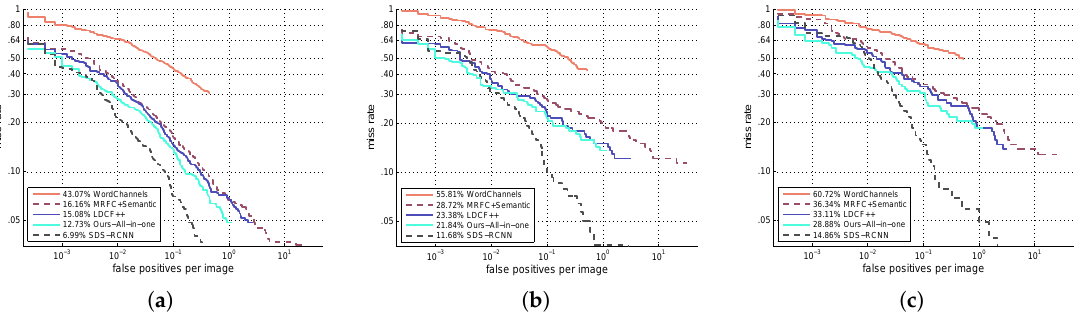
Figure 10. Evaluation results under conditions of small scale, atypical aspect ratio and partial occlusion. ( a ) Small scale (50 px ≤ h ≤ 80 px); ( b ) Atypical aspect ratio ( | w / h − 0.41 | ≥ 0.1); ( c ) Patial occlusion (0–35% occluded).